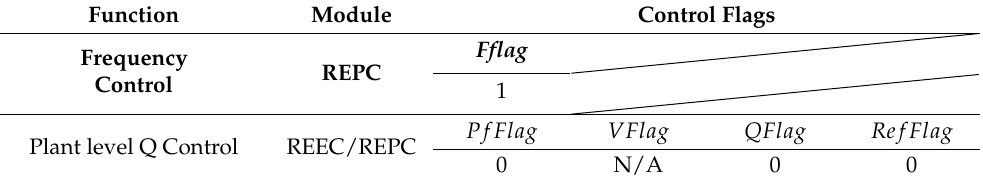
Table 4. The model flag settings of the frequency control and reactive power control.